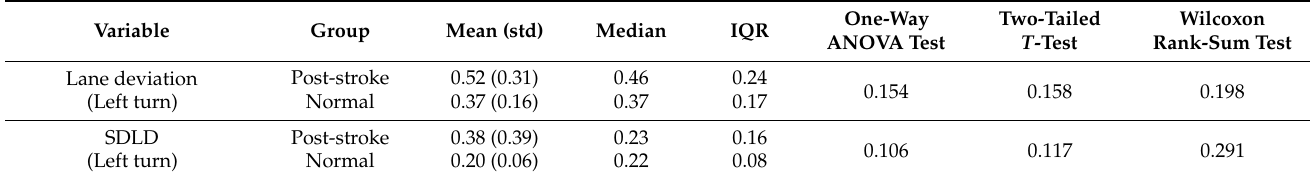
Table 3. Statistical tests of lane keeping performance in left turn.